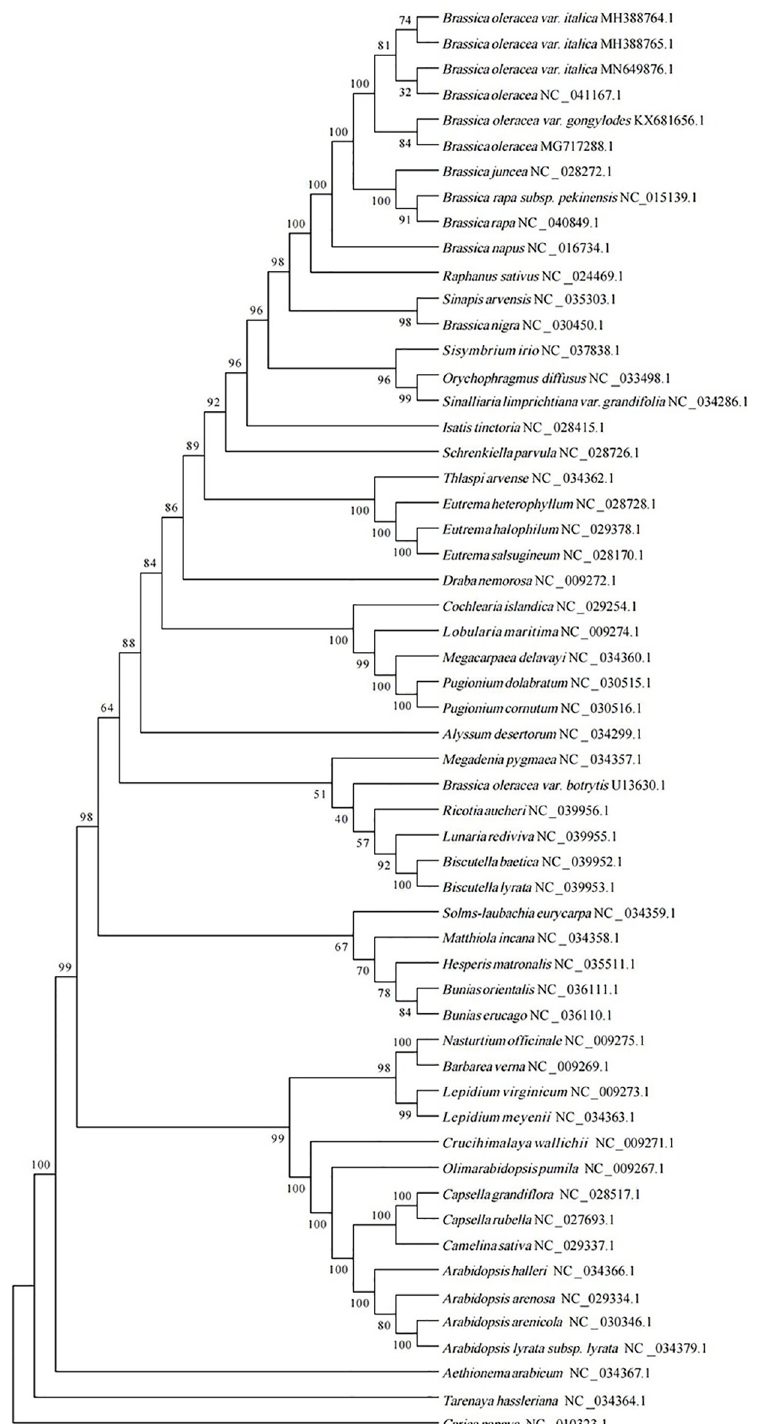
Fig 5. Phylogenetic tree inferred by the maximum likelihood method based on the complete cp genomes from 56 species. Bootstrap support values are shown at the nodes.